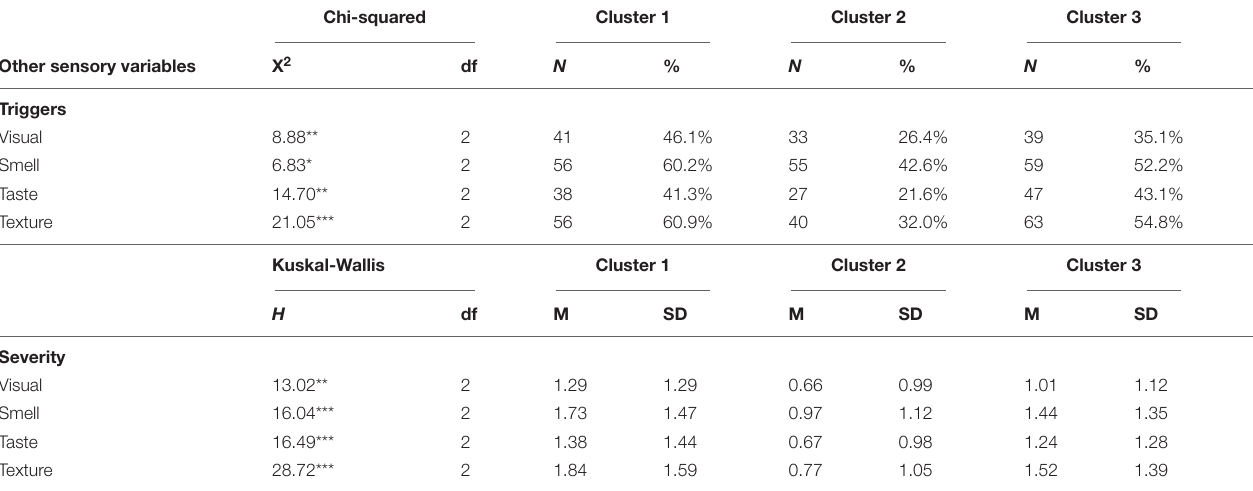
TABLE 7 | Clustering behavior and kruskal-wallis test results for other sensory triggers based on the three-cluster solution. Chi-squared Cluster 1 Cluster 2 Cluster 3